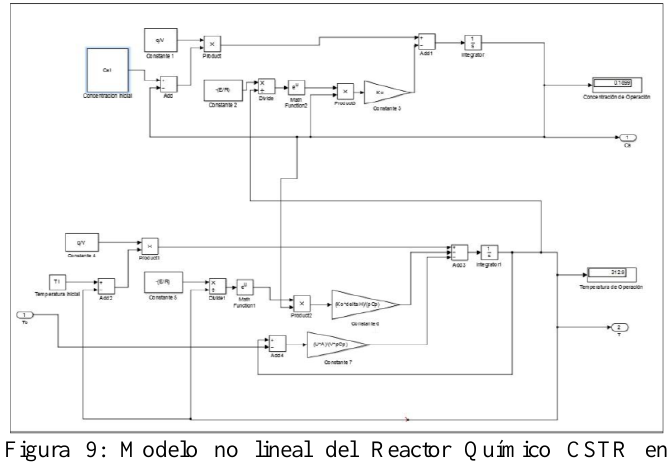
Figura 8: Oscilación sostenida con período 𝑷 Fuente: Los Autores, (2018). 4. Establecer los valores de 𝐾 y 3.